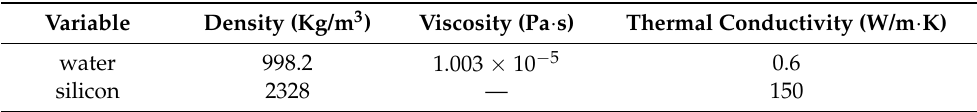
Table 1. Parameters of water and silicon at room temperature at 1 atm.